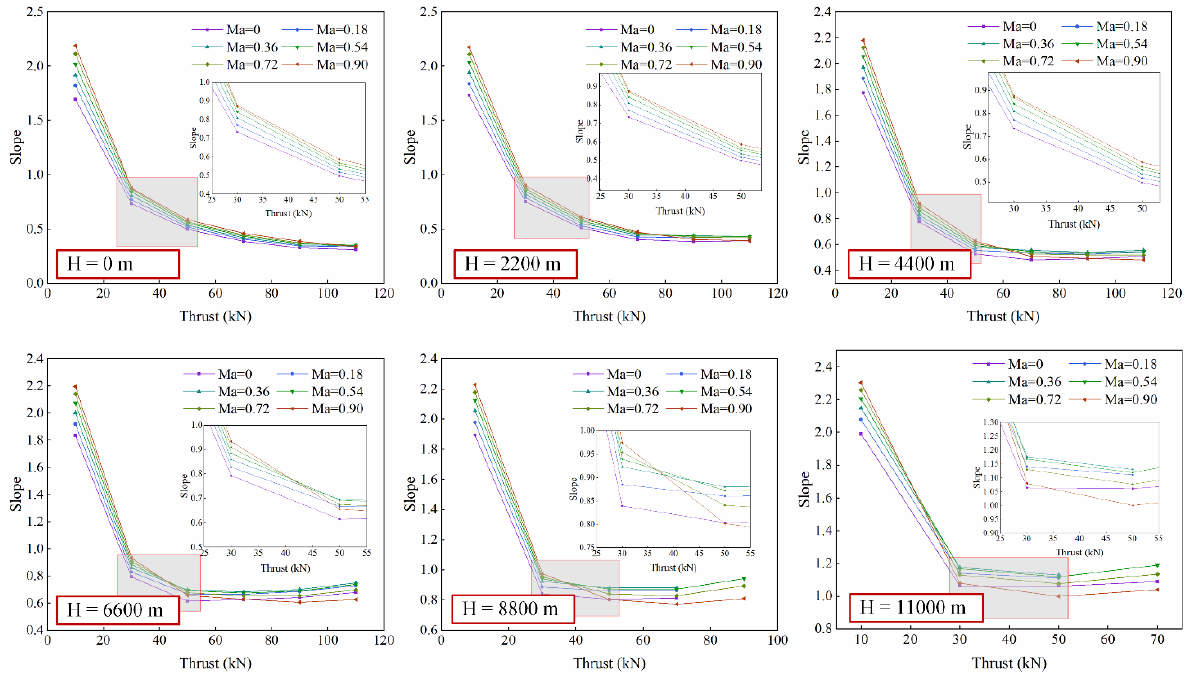
Figure 5. Influence of bleed air on the slope of the fitted line.